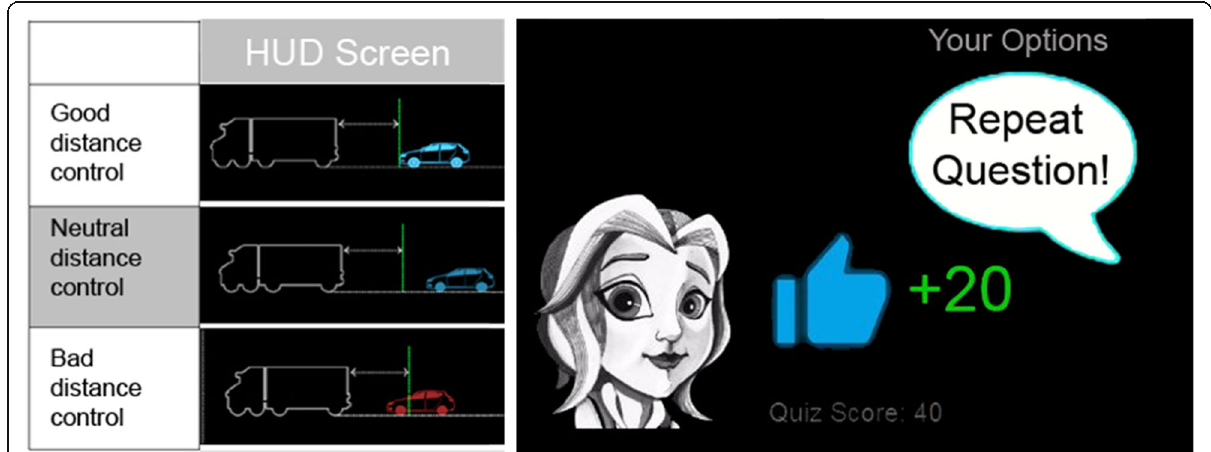
Fig. 3 Feedback via HUD (left) and centre console (right) during the driving game “ keep distance